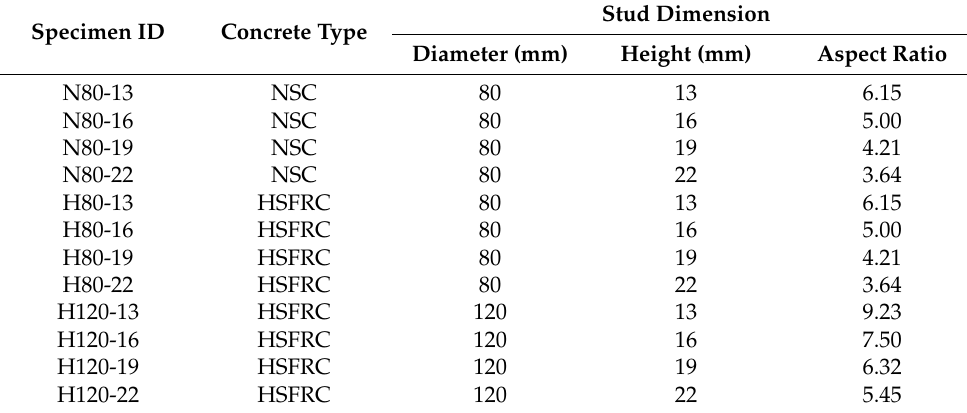
Table 1. Details of the push-out specimen.